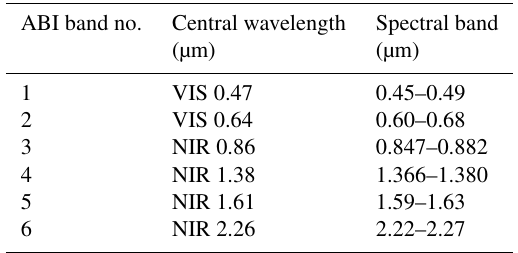
Table 1. Channel information and spectral bands for ABI. ABI band no.